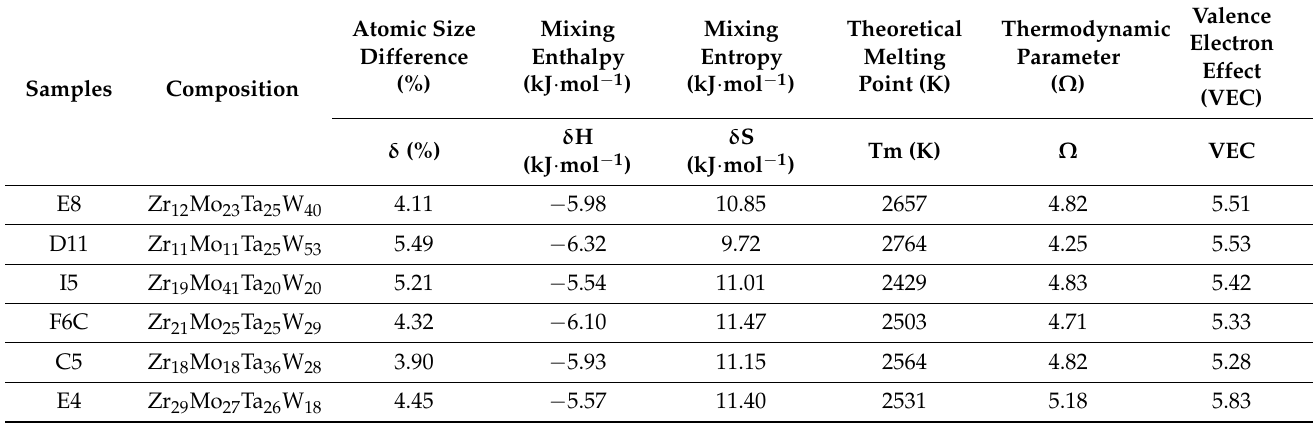
Table 3. Thermodynamic parameters of the ZrMoTaW RMPEA thin films with different compositions.